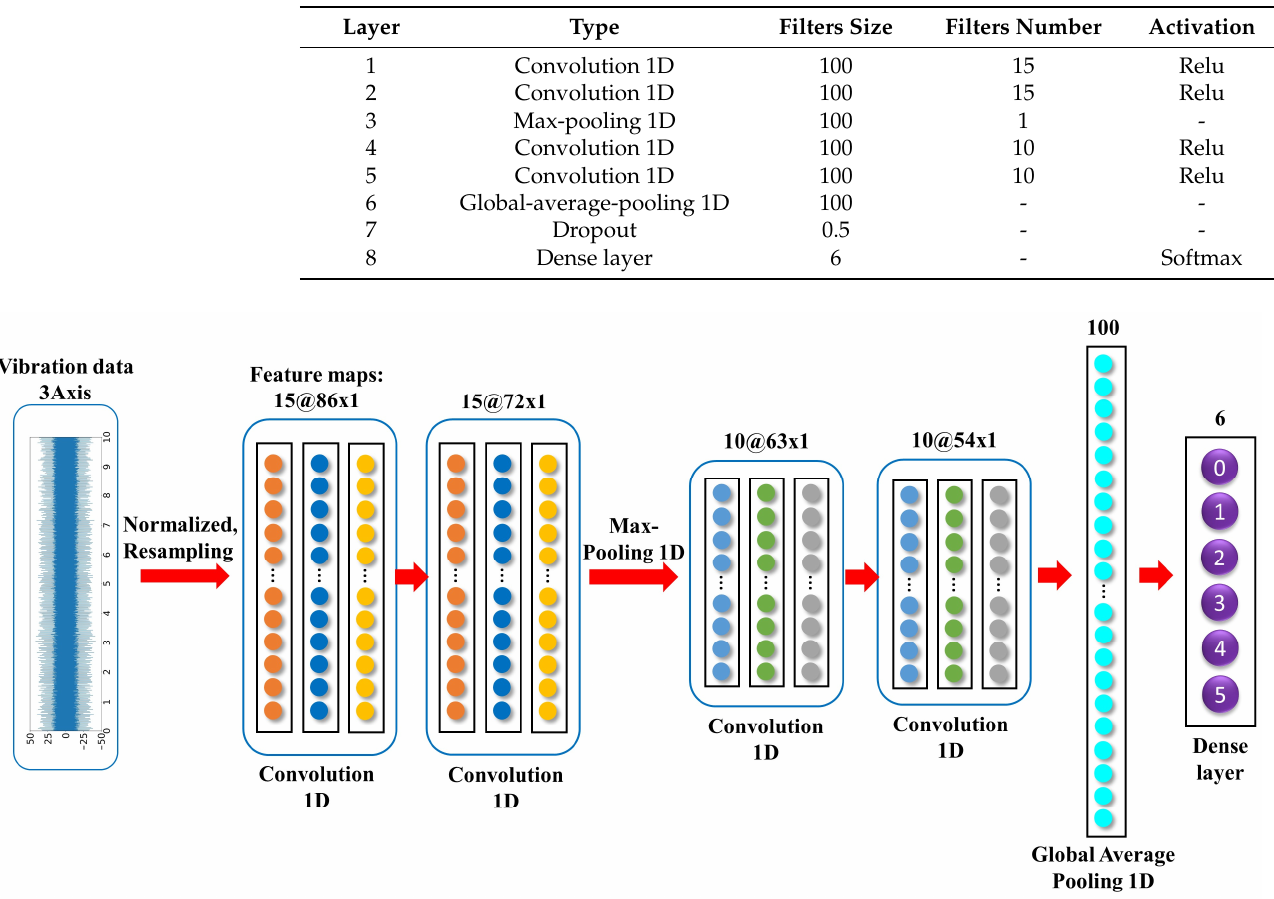
Table 5. D CNN structure.